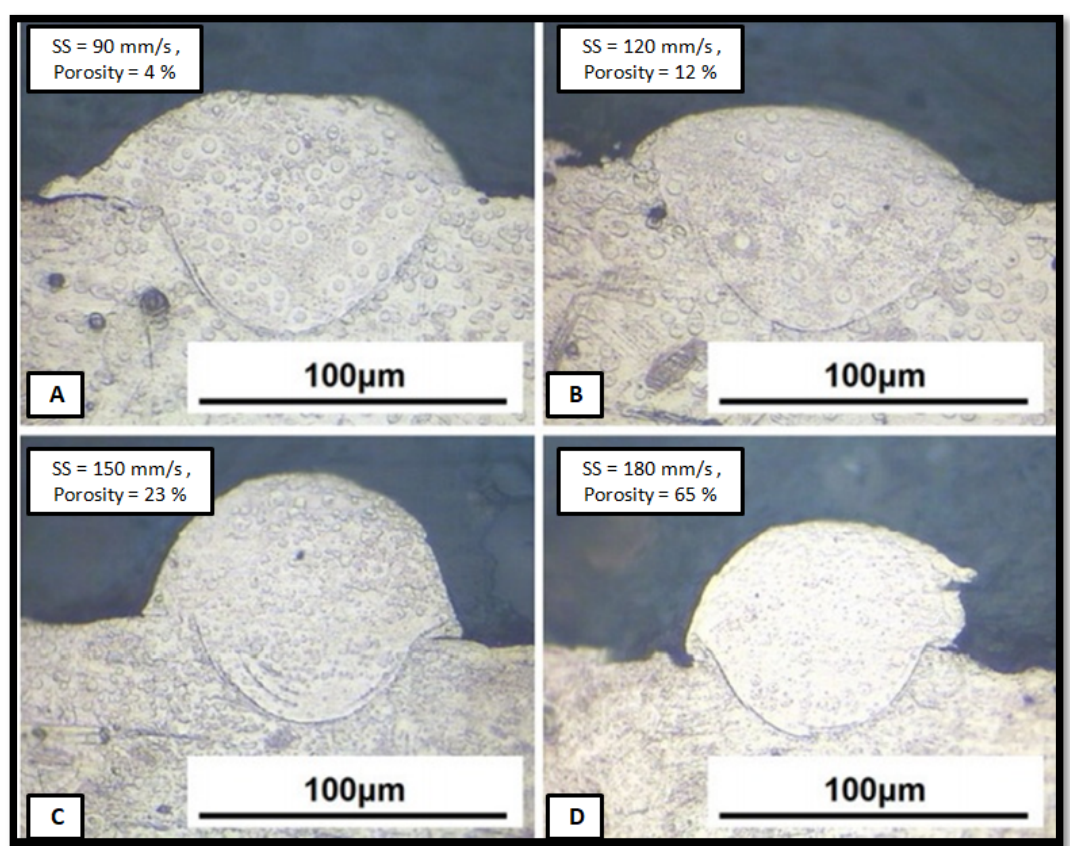
Figure 12. Molten tracks at different scanning speed: ( a ) 90 mm/s ( b ) 120 mm/s ( c ) 150 mm/s ( d ) 180 mm/s with corresponding porosities of 4%, 12%, 23%, and 65% [9].